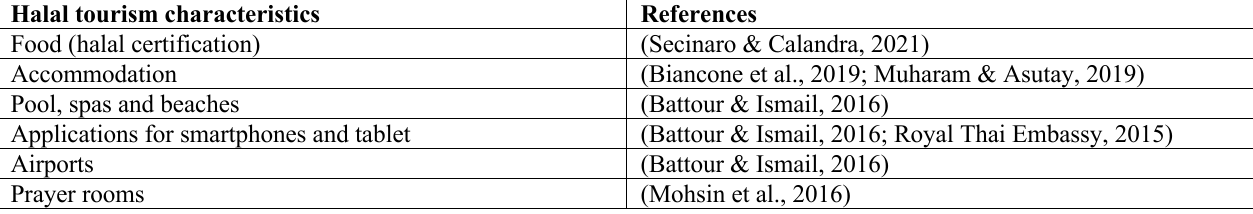
Table 1. Halal tourism